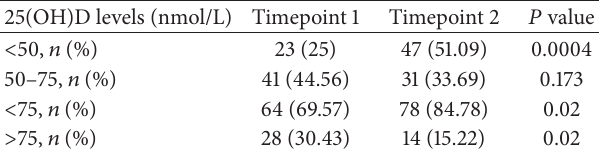
Table 2: Distribution of patients in four categories according to 25(OH)D levels at timepoint 1 and timepoint